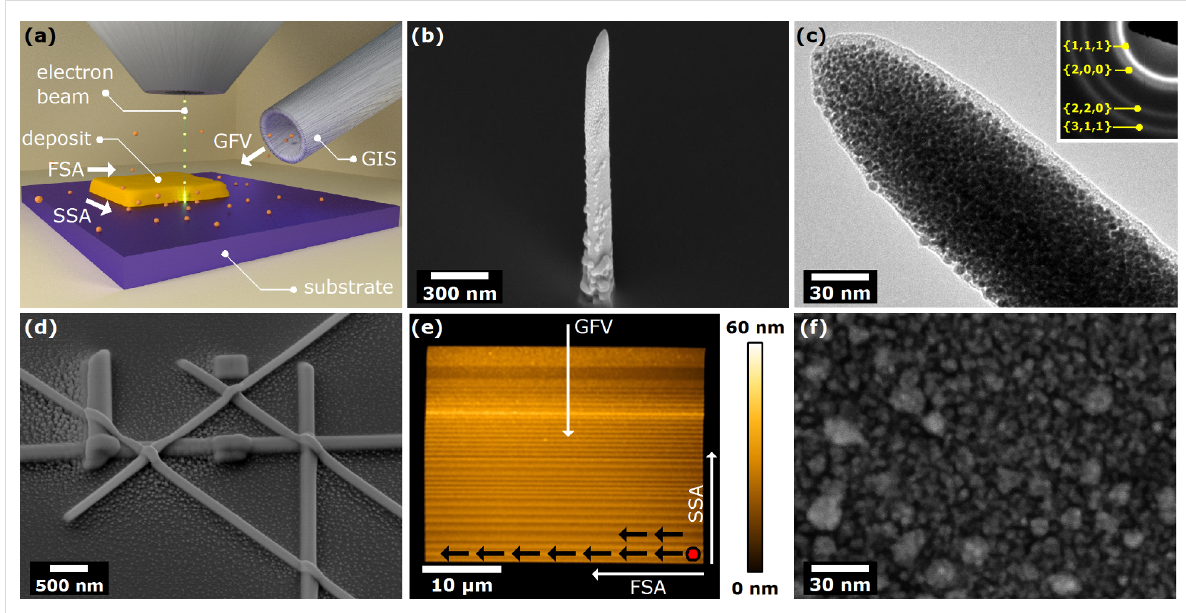
Figure 1: (a) Schematics of the FEBID experimental set-up. Note that the direction of electron beam movement, i.e., fast scanning axis (FSA) and slow scanning axis (SSA), can be adjusted relative to the gas flux vector (GFV). (b) SEM image (45° tilt) of a Au nanopillar (NP) fabricated by FEBID. (c) TEM image of a FEBID Au NP, with the corresponding electron diffraction pattern given in the inset, confirming the polycrystalline nature of the NP. (d) SEM image (45° tilt) showing a group of various Au nanostructures produced by FEBID. (e) AFM topographic image of a relatively large planar Au structure made by FEBID. Electron beam scanning strategy was adjusted so that FSA is perpendicular to GFV, whereas SSA was opposite to GFV. Note the height variation of the deposit in direction of SSA. (f) HAADF-STEM image (top view) of a section of a planar FEBID Au structure, deposited on a thin silicon nitride